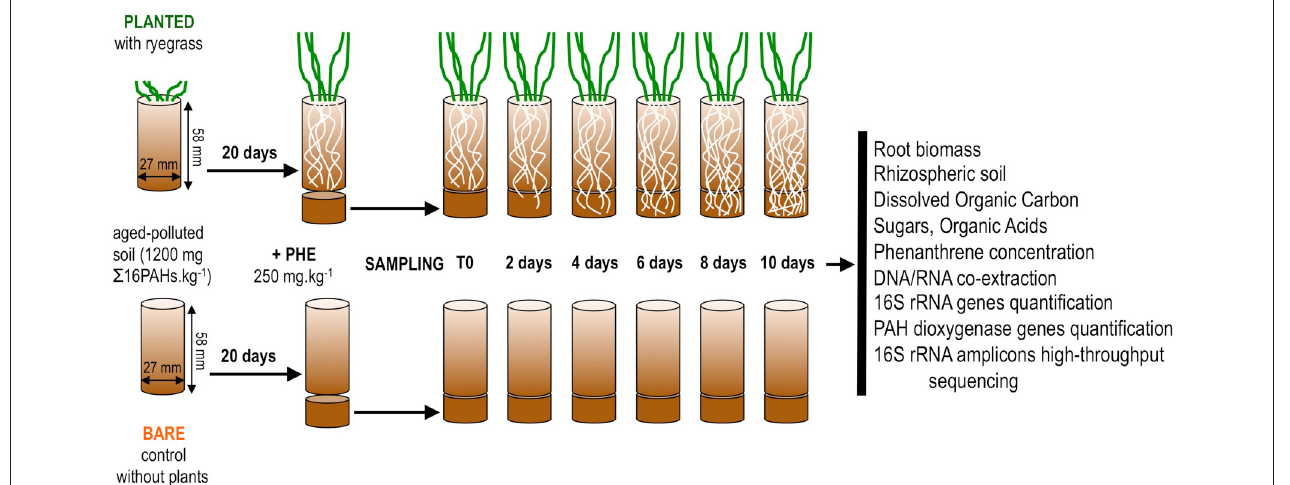
FIGURE 1 | Schematic summary of the microcosm set-up and subsequent sample